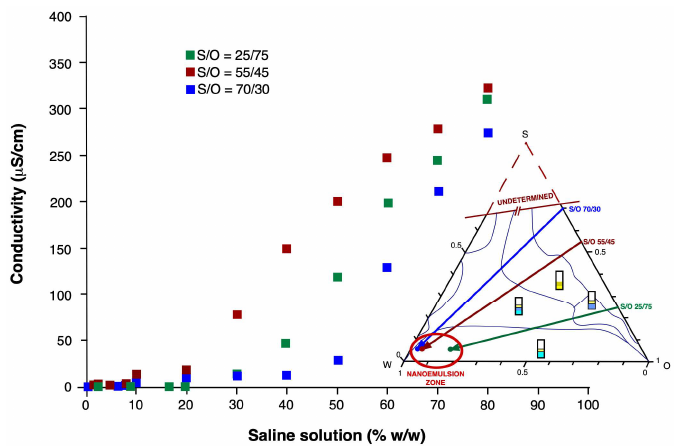
Figure 2. Conductivity as a function of the weight percent of 0.01 M NaCl aqueous solution for HLB = 12 emulsions with an S/O relation of 25/75, 55/45, and 70/30 at 30 °C. When water is added to the dilution line where the ratio S/O is the highest and S/O = 70/30, it is observed that the conductivity is constant (20 µ S.cm − 1 ) from 20 to 40 wt% in the biphasic region (Om + LC). When the amount of water reaches 50 wt%, the dispersion is inside the area (O + LC + W), and the conductivity increases linearly as a function of the amount of added water, which confirms that the water is the external phase of the